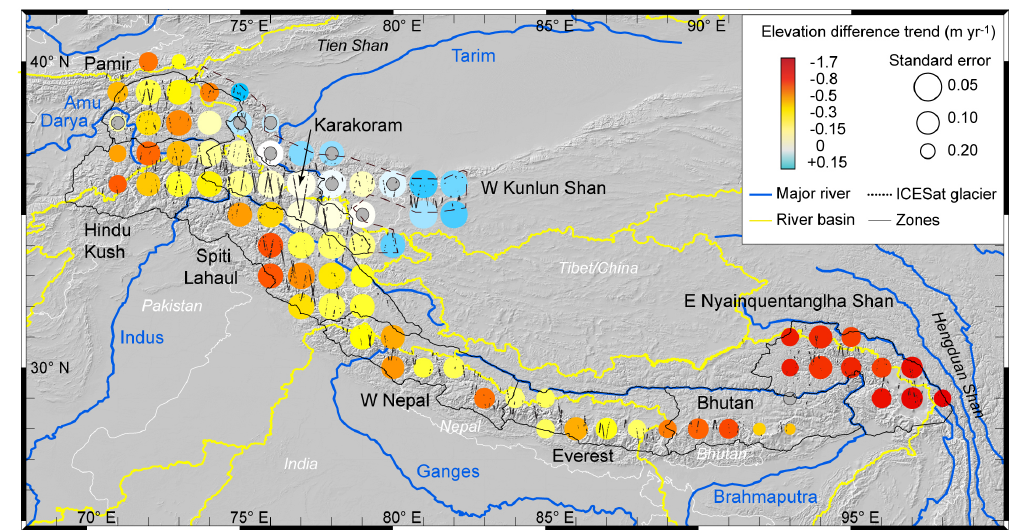
Figure 1. Study region and trends of elevation differences during 2003–2008. Data are shown on a 1 ◦ grid with overlapping rectangular geographic averaging cells of 2 ◦ × 2 ◦ . Trends are based on autumn ICESat acquisitions. Only ICESat footprints over glaciers are indicated. The zones indicated by black outlines are equivalent to the ones of Gardelle et al. (2013) with the western Kunlun Shan–Tarim zone (dashed outline) being the only additional one. Trends for all cells (coloured data circles) are statistically significant except for the cells that are marked with grey centres. The uncertainty of the temporal trends per cell is indicated through circle sizes indirectly proportional to the standard error of trends at 68%